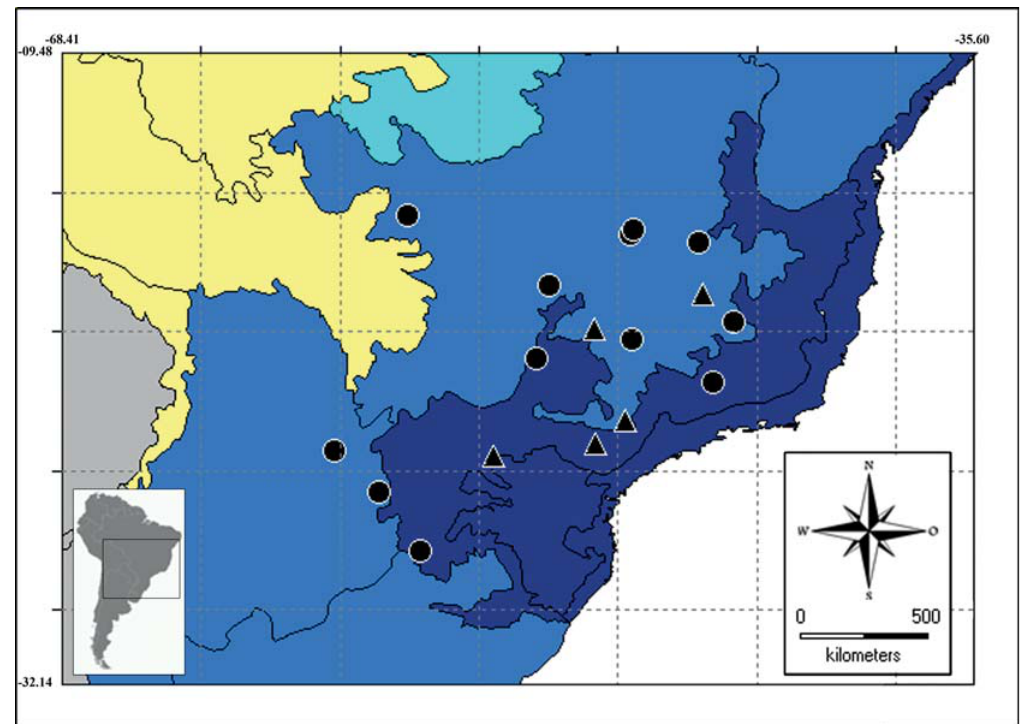
Fig. 8. Geographical distribution of Canthidium kelleri (Martínez et al ., 1964) (circles) and Canthidium ayri sp. nov.